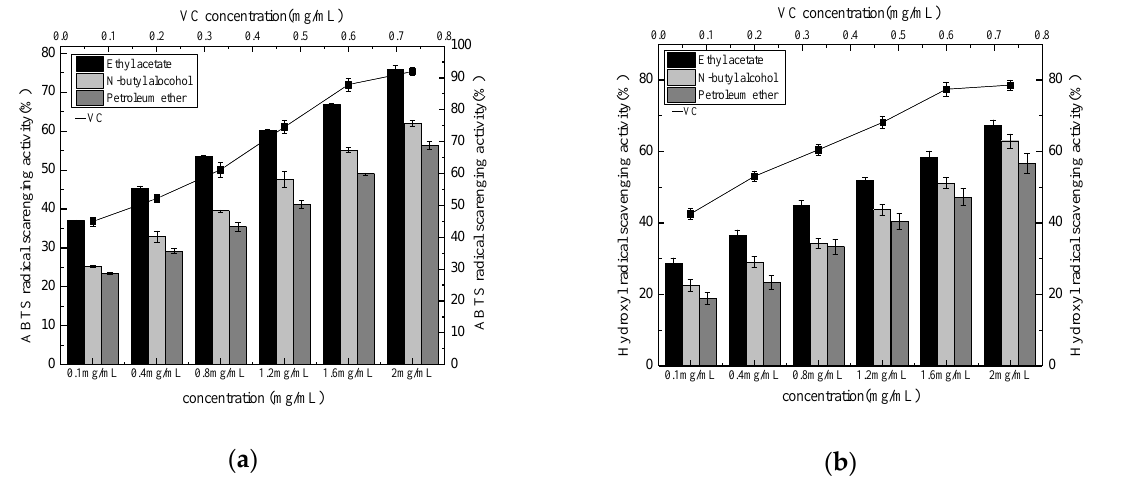
Figure 8. ABTS+ free radical scavenging of different extraction phase ( a ) and hydroxyl radical scavenging activity of different extraction phase ( b ). Table 9. Scavenging effect of Pleioblastus amarus (Keng) shell with different extraction phases on ABTS+ free radical.